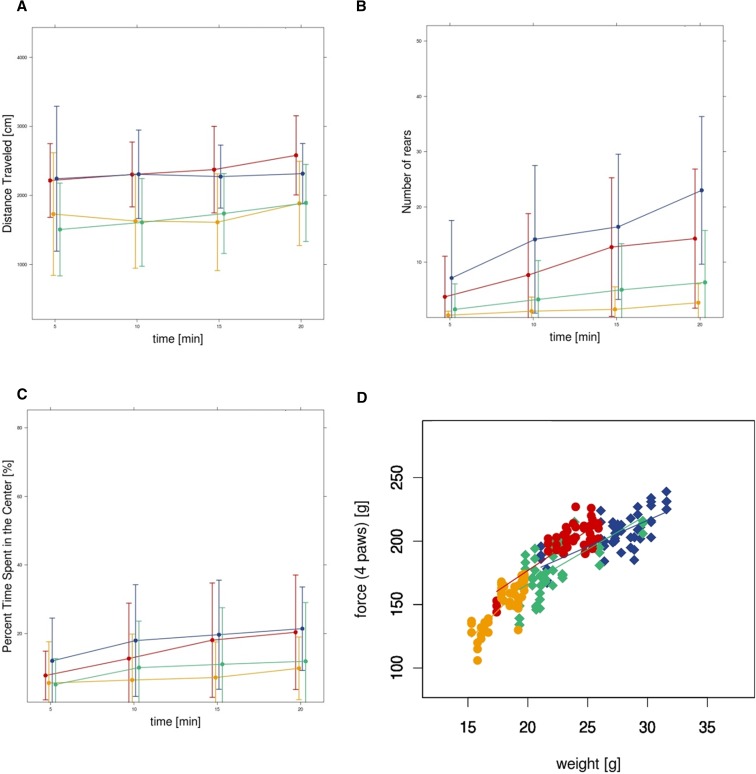
Analysis of Scube3N294K/N294K mice in the Open Field test and grip strength analysis. Data for distance traveled (A), number of rears (B), and percent time spent in center (C) are shown over the 20 min test interval. Grip strength (four paw measurement) is plotted vs. body weight (D) (green, Scube3N294K/N294K males; yellow, Scube3N294K/N294K females; blue, Scube3WT males; and red, Scube3WT females).